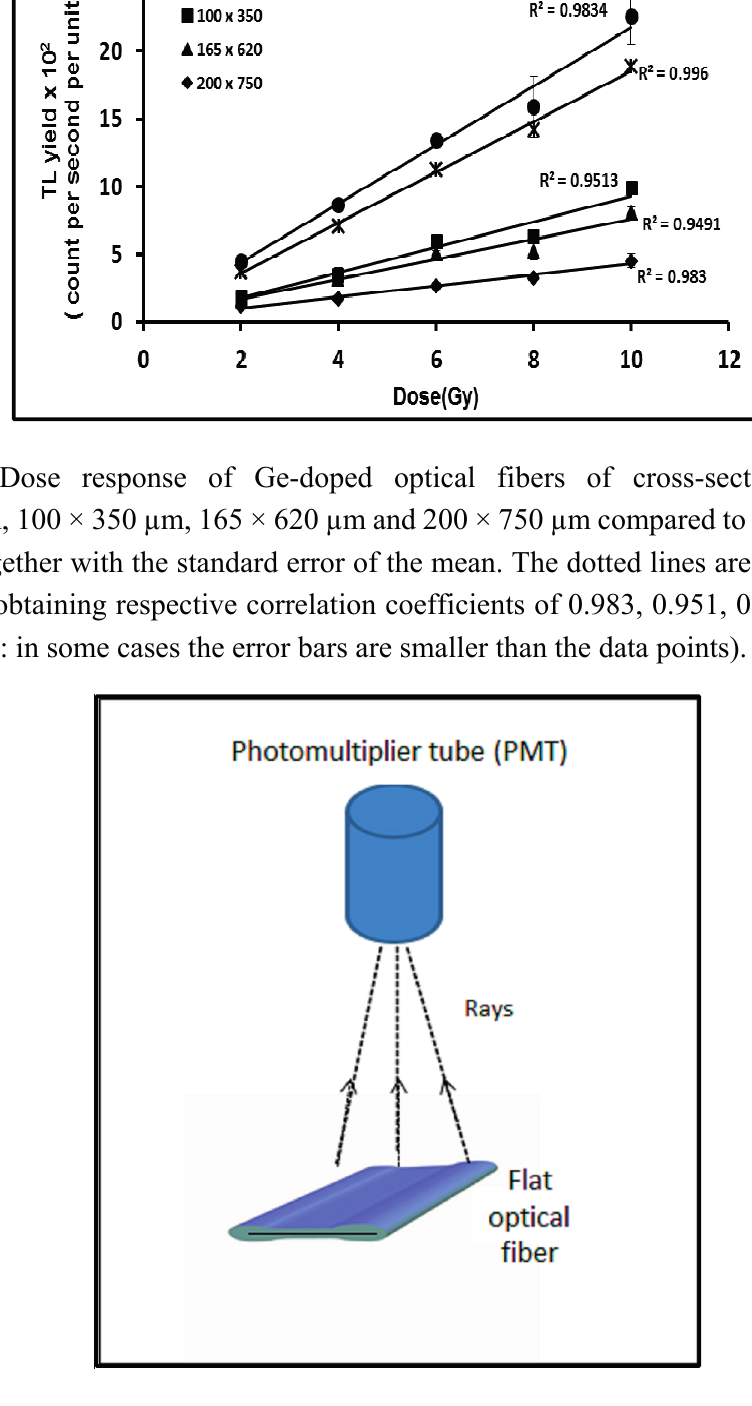
Figure 4 . The position of flat optical fibers vie wed by a centrally located fixed position TLD Reader photomultiplier tube. (Note: the line on the flat optical fiber represents the core containing the Ge